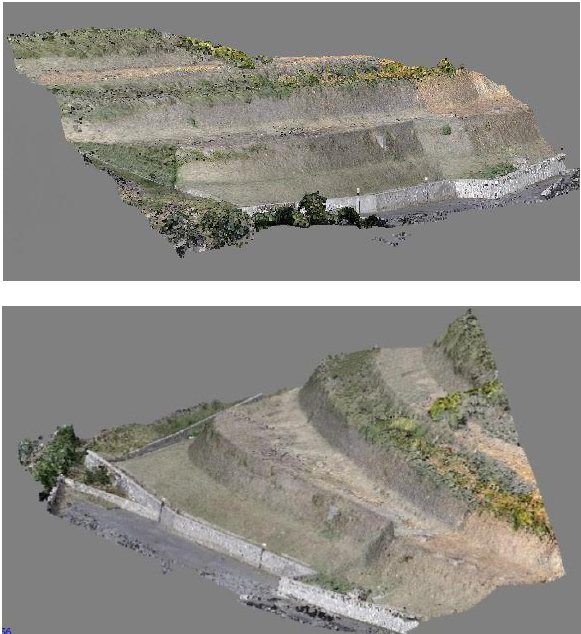
Figures 6a and 6b. Different angles of the dense cloud